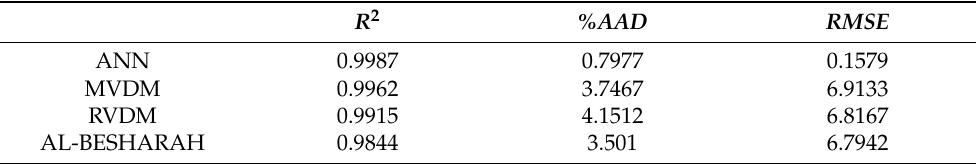
Table 8. Using Al-Besharah data to compare the accuracy of the models (limited data).